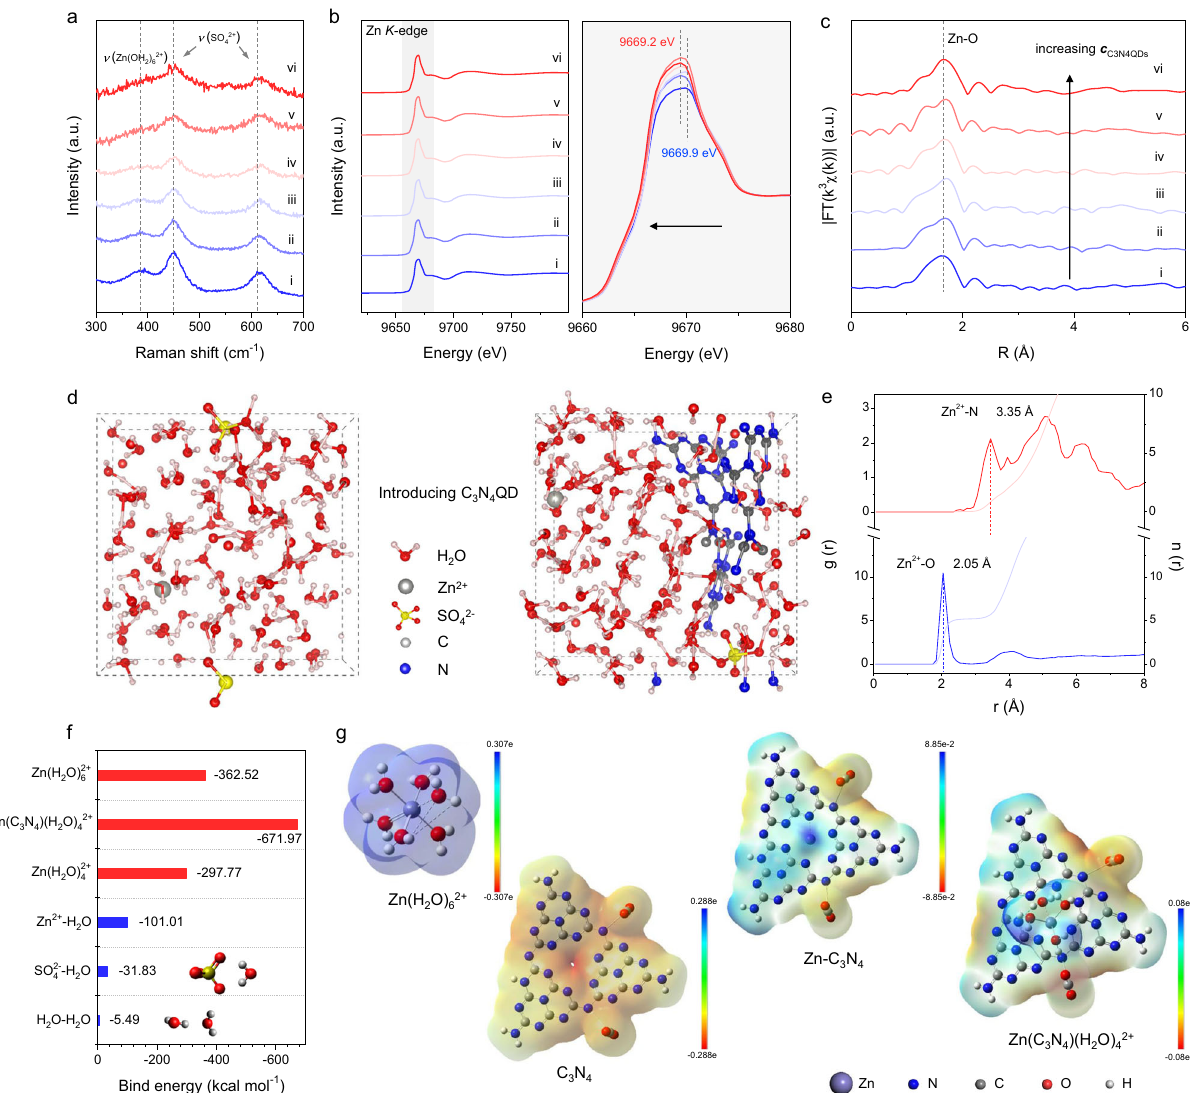
Fig. 1 | The structural characterization of ZnSO 4 -C 3 N 4 QDs electrolyte. a Raman spectra, b XANES spectra and c Fourier transformed EXAFS spectra of (i) pristine 2M ZnSO 4 , (ii) 2M ZnSO 4 +0.1mgml − 1 C 3 N 4 QDs, (iii) 2M ZnSO 4 +0.5mgml − 1 C 3 N 4 QDs, (iv) 2M ZnSO 4 +1mgml − 1 C 3 N 4 QDs, (v) 2M ZnSO 4 +2mgml − 1 C 3 N 4 QDs, (vi) 2M ZnSO 4 +4mgml − 1 C 3 N 4 QDs; d The 3D snapshot of the ZnSO 4 -C 3 N 4 QDs